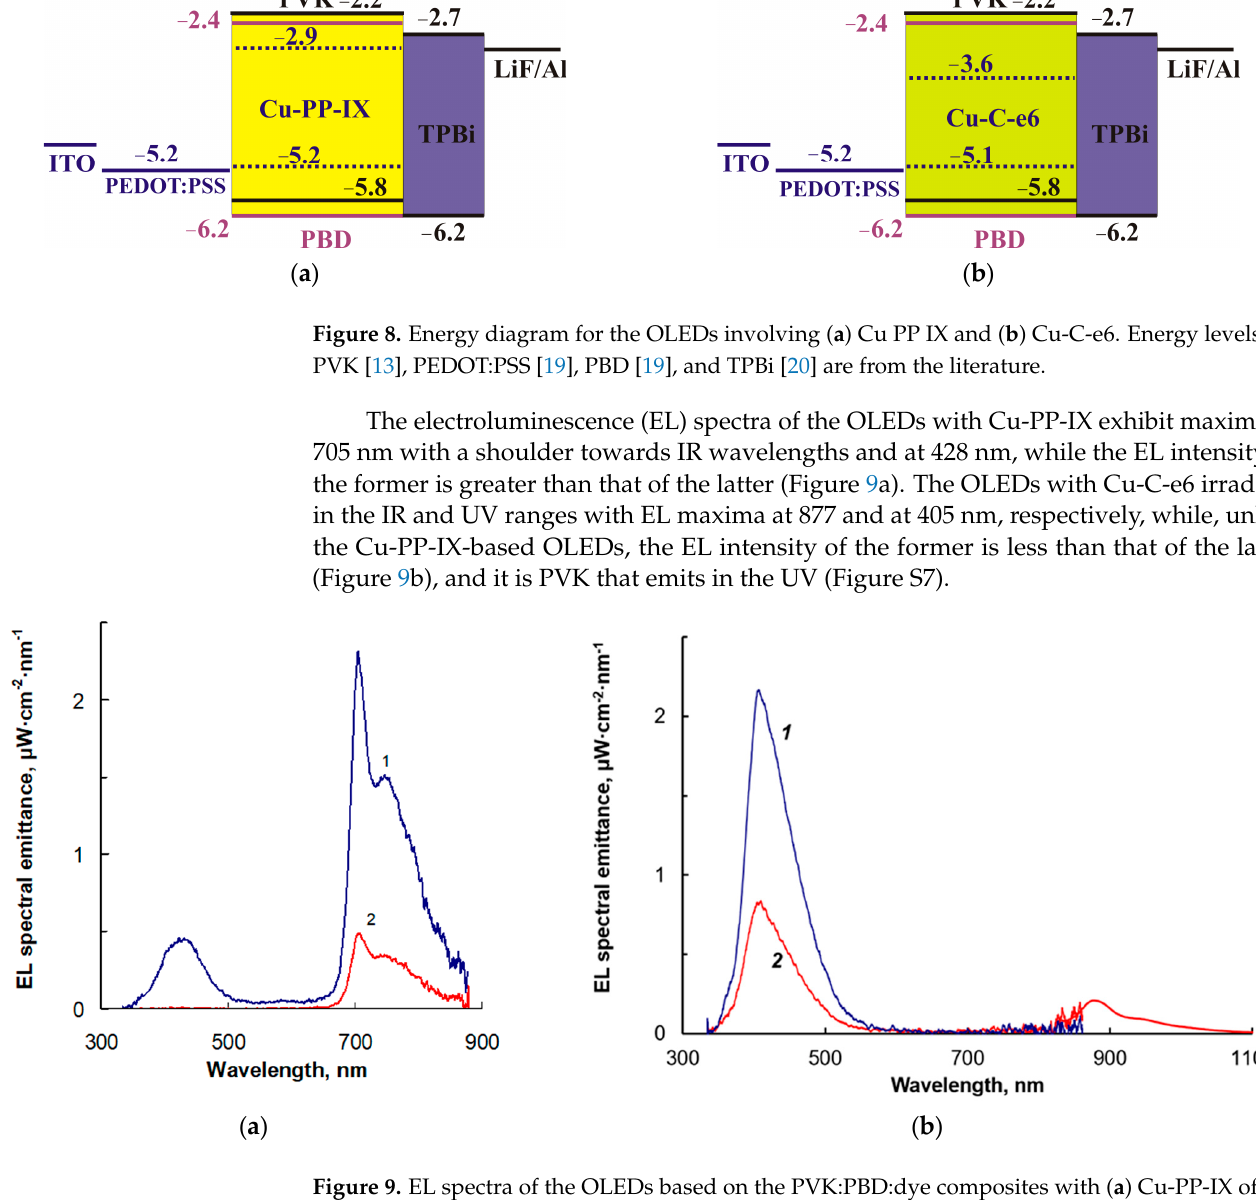
Figure 7. I ‐ V curve of photocurrent (1, 3) and dark current (2, 4) for diodes based on the Cu ‐ PP ‐ IX (1, 2) and Cu ‐ C ‐ e6 (3, 4) dyes.